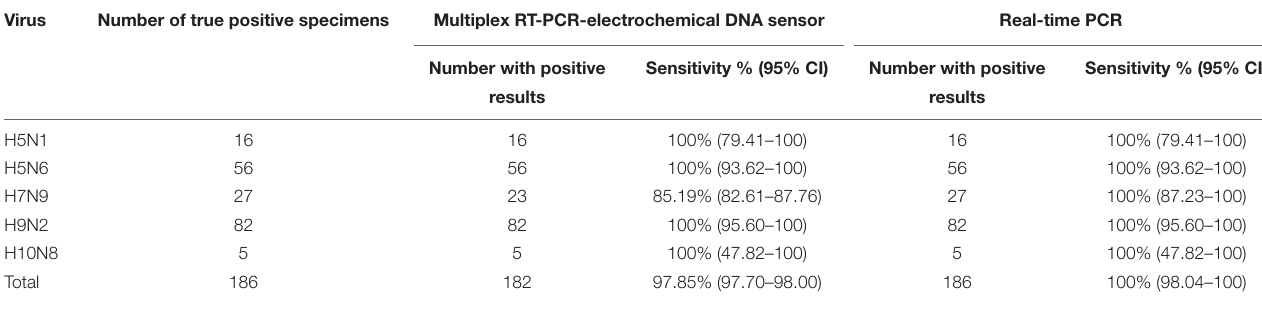
TABLE 3 | Comparison of the detection sensitivity for the avian influenza virus-positive specimens between the multiplex RT-PCR-electrochemical DNA sensor and the real-time PCR kits. Virus Number of true positive